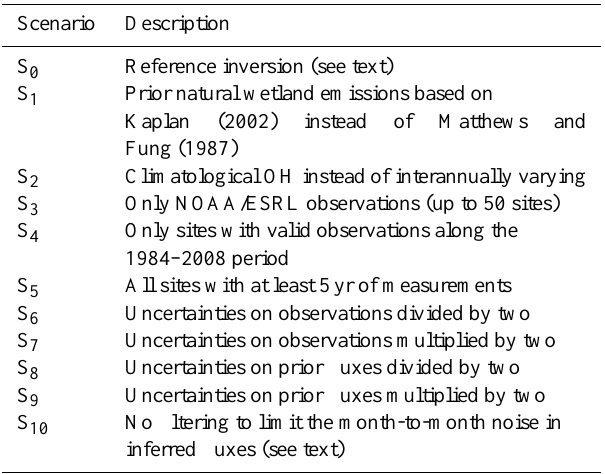
Table 1. Description of the 11 inversions defining INV1